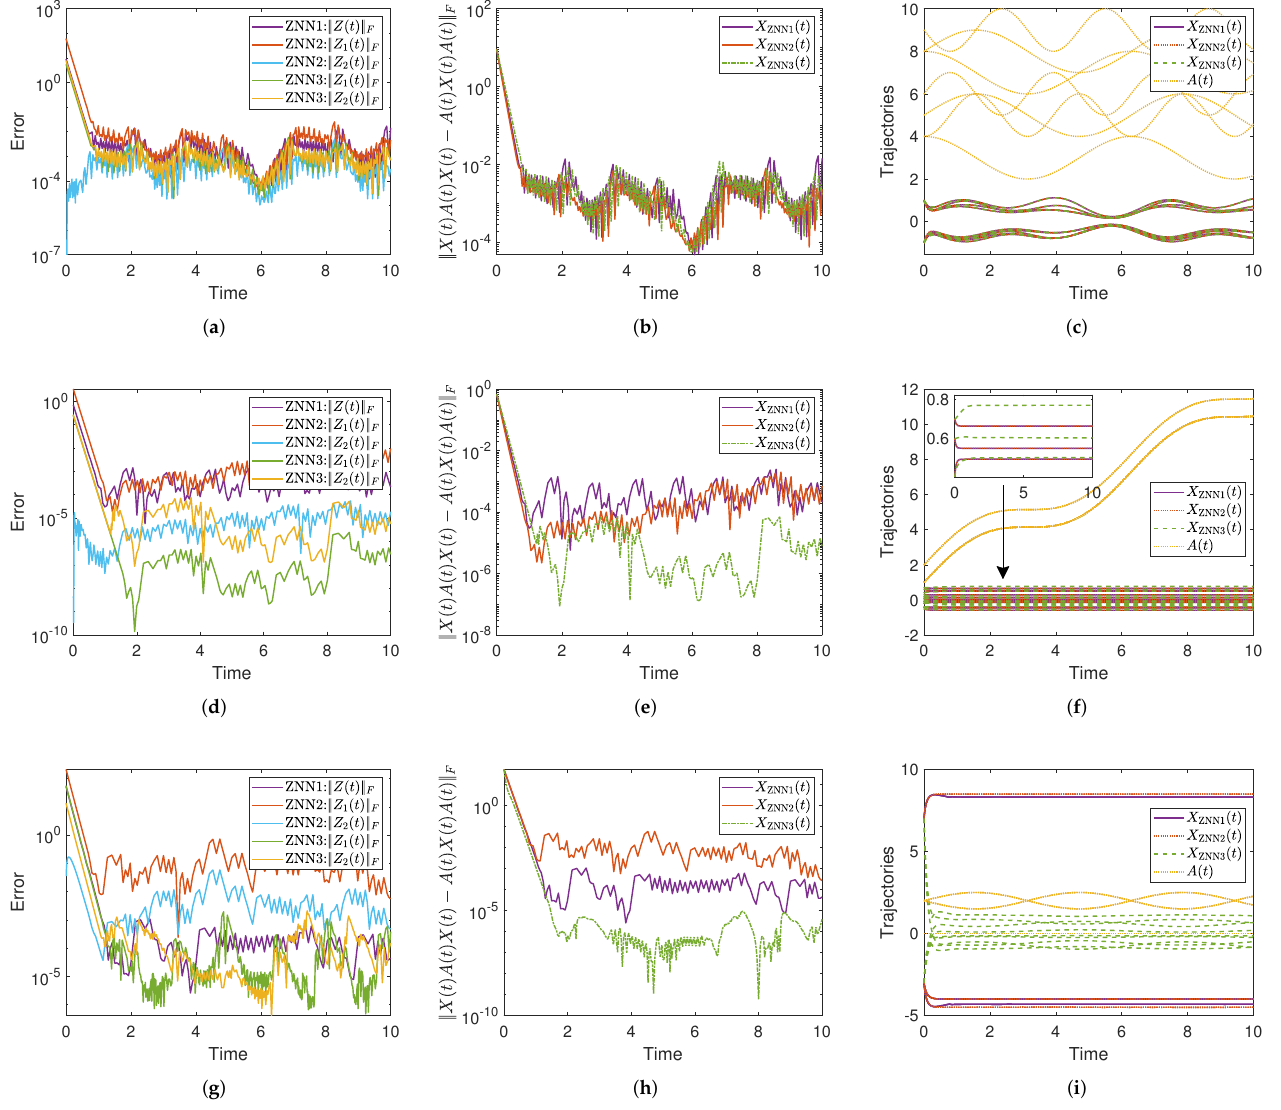
Figure 1. The ZNN error tracking and the convergence and trajectories of the solutions in Sections 4.1–4.3. ( a ) Section 4.1: ZNN error tracking. ( b ) Section 4.1: Solutions convergence. ( c ) Section 4.1: Solutions trajectories. ( d ) Section 4.2: ZNN error tracking. ( e ) Section 4.2: Solutions convergence. ( f ) Section 4.2: Solutions trajectories. ( g ) Section 4.3: ZNN error tracking. ( h ) Section 4.3: Solutions convergence. ( i ) Section 4.3: Solutions